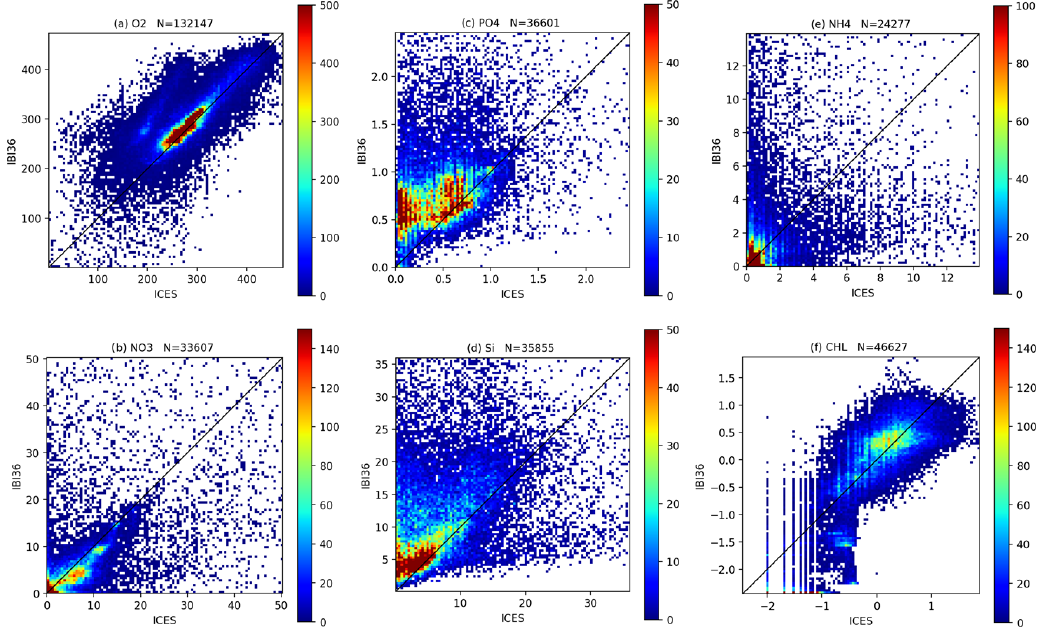
Figure 8. Density plots for (a) oxygen, (b) nitrate, (c) phosphate, (d) silicate, (e) ammonium and (f) log10(Chl a ). ICES data are on the x axis and IBI36 on the y axis. Oxygen and nutrients are expressed in µmolL − 1 . Each axis is divided in 100 bins and the colour bar represents the density of the match-ups (number of overlapping points). Note the different scales for the variables. N indicates the total number of match-ups. Daily averaged IBI36 outputs and ICES data are collocated in space and time between 2010 and 2016. All depths are presented, keeping in mind that ICES data are mainly located in the shallow and coastal waters of the northern